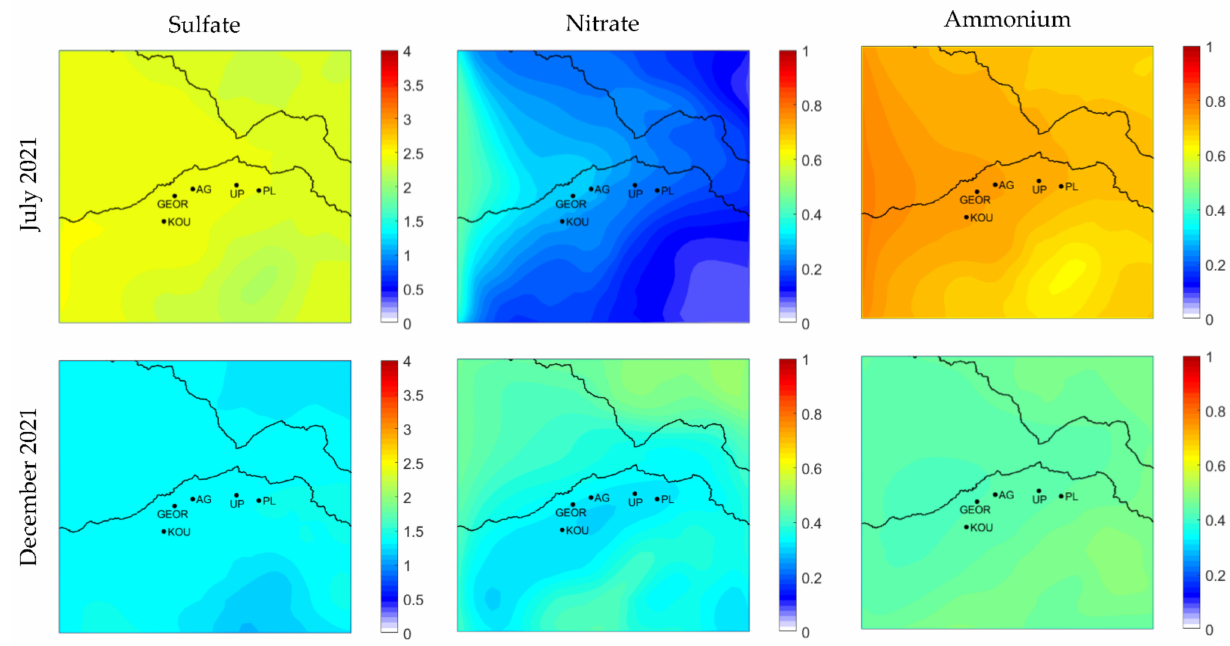
Figure 8. Predicted average ground concentrations ( µ g m − 3 ) of PM 2.5 sulfate, nitrate and ammonium during July and December 2021 for the inner domain including Patras at 1 × 1 km 2 resolution. Different scales are